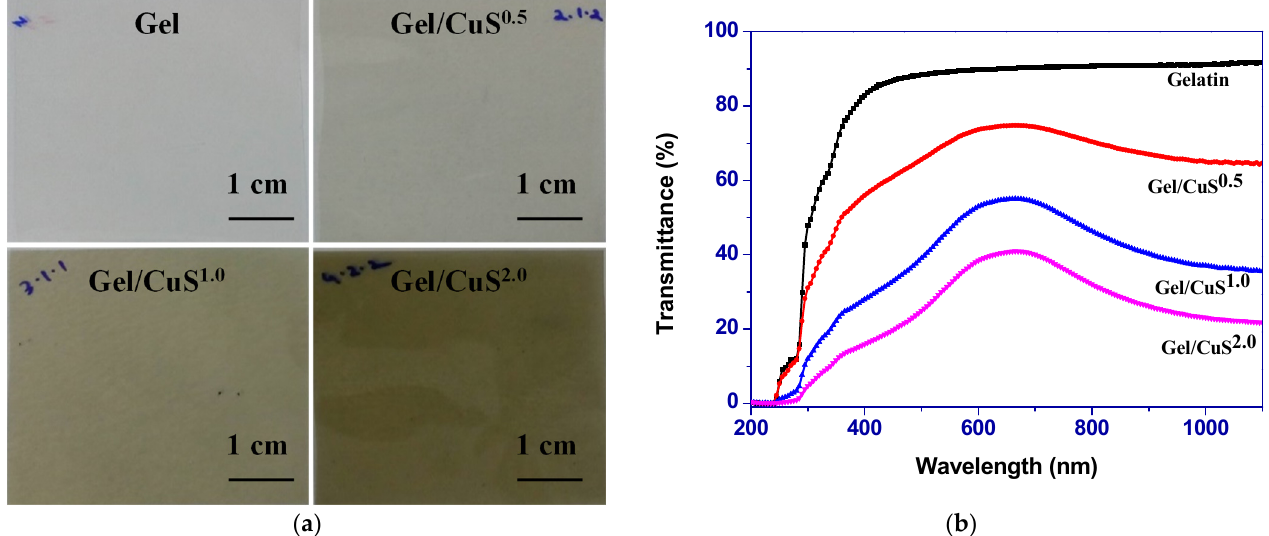
Figure 2. Appearance ( a ) and UV-vis transmittance spectra ( b ) of Gel/CuSNP films. Table 2. Optical properties of gelatin/CuSNP films.